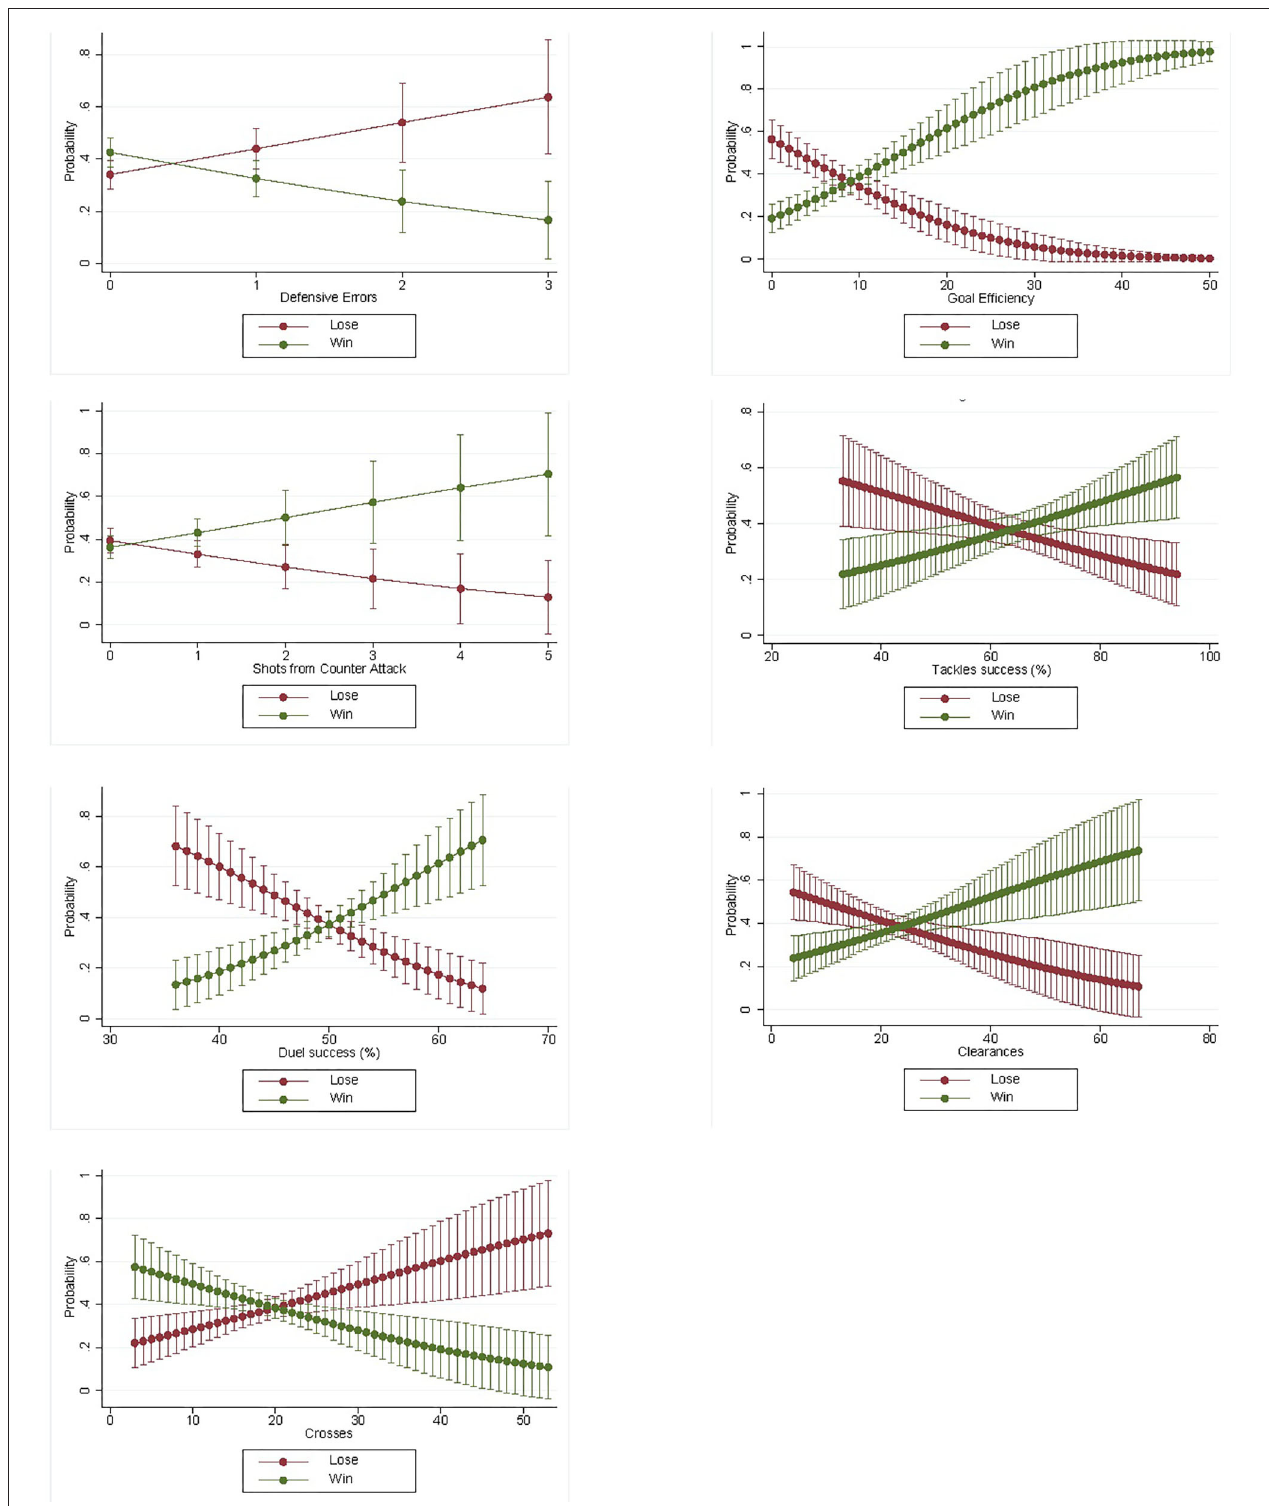
FIGURE 1 | Margins with 95% CIs of the significant